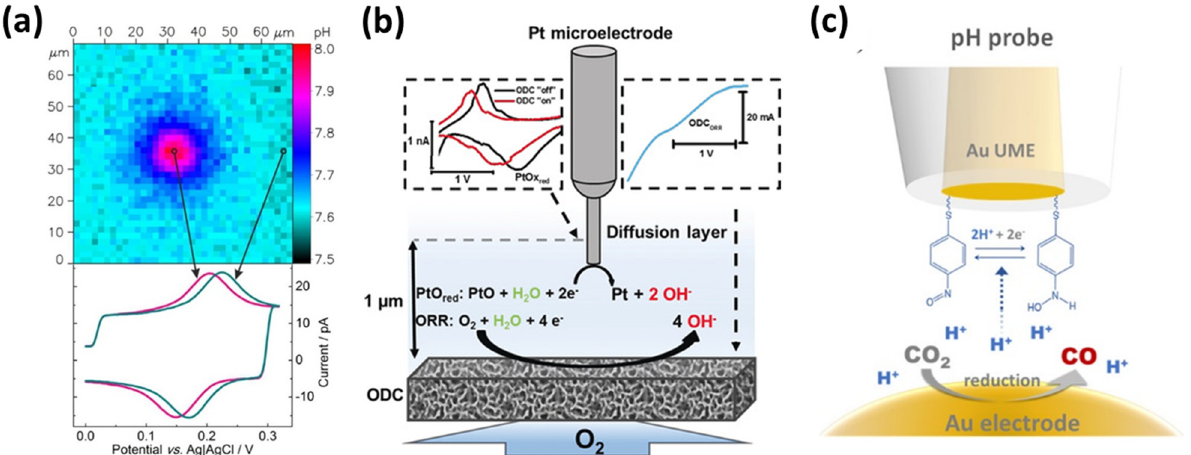
Figure 8. ( a ) 3D map with local pH values during ORR at a Pt UME. Adapted from ref. [36]. Copyright (2015) with permission from the American Chemical Society. ( b ) Depiction of the pH measurements at the surface of a working oxygen depolarized cathode. Reprinted from ref. [71]. Copyright (2018) with permission from John Wiley and Sons. ( c ) Scheme showing local pH measurements during CO 2 reduction at an Au electrode. Adapted from ref. [46] under CC BY-NC-ND 4.0 license.